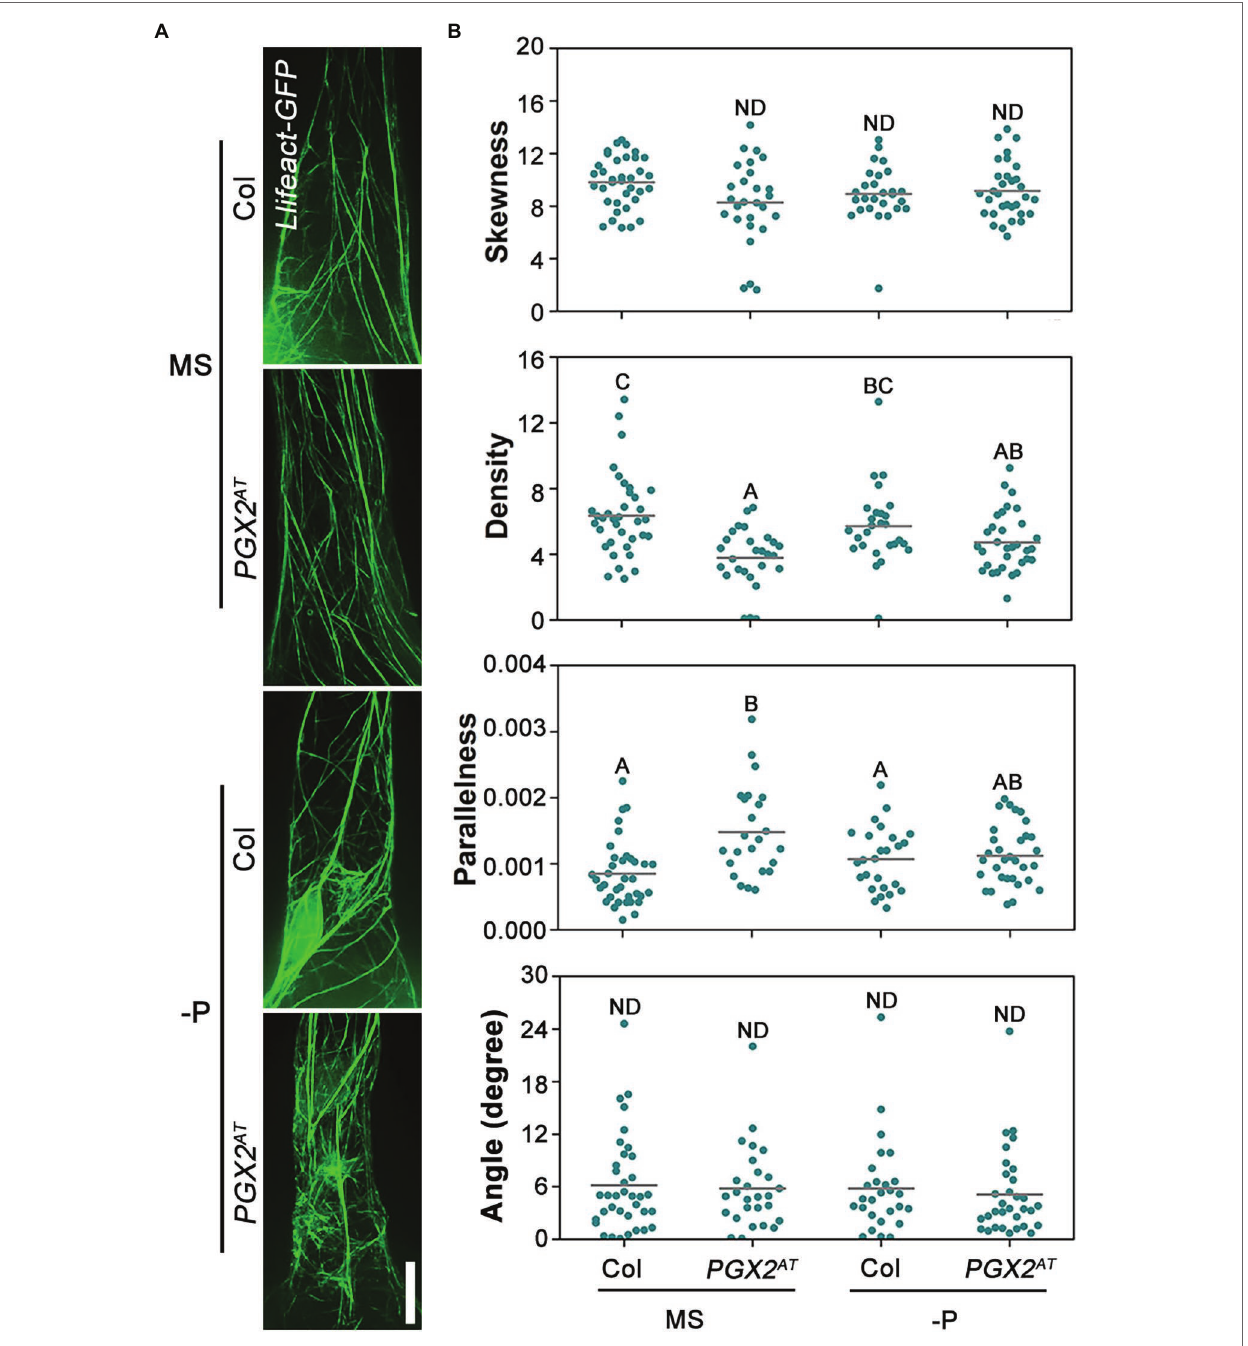
FIGURE 7 | Actin filament skewness is recovered in PGX2 AT root hair cells after NPA treatment. (A) Actin filaments in root hairs of Lifeact-GFP Col and Lifeact-GFP PGX2 AT transgenic seedlings in the 4th day after transferring into normal MS or P-deficient conditions. The 5 μ m NPA was added into media for seedling growth. Bars = 10 μ m. (B) Skewness, density, parallelness, and angle of actin filaments were quantified by ImageJ ( n ≥ 27 cells). Uppercase letters indicate significantly different groups as determined by one-way ANOVA with post-hoc Duncan testing ( p < 0.01). ND, no statistical